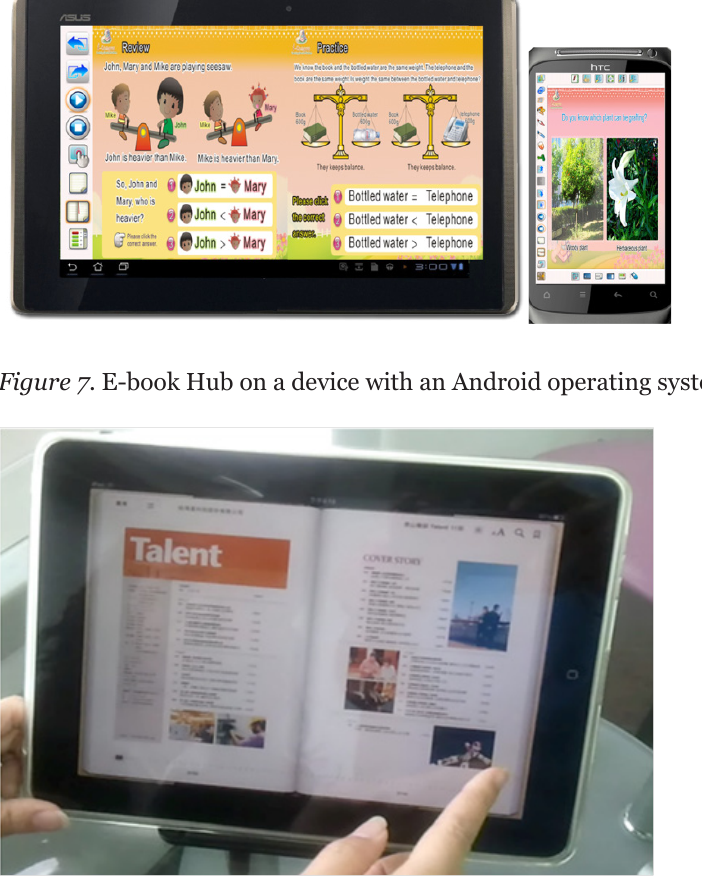
Figure 8 . E-book Hub displaying an EPUB